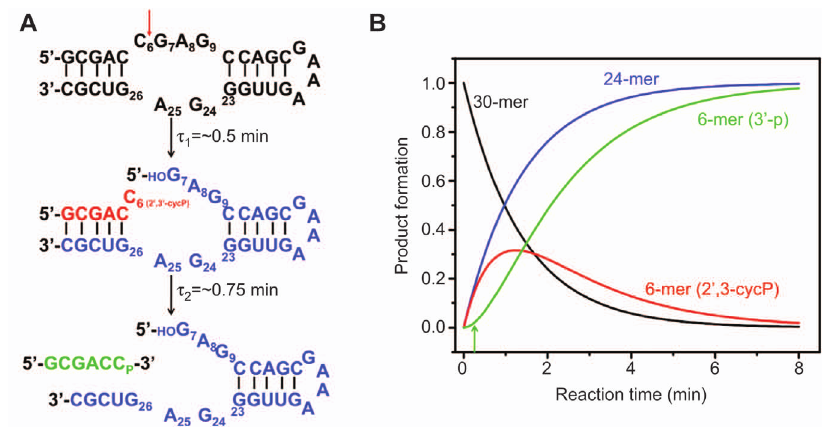
Figure 2 Cleavage reaction of leadzyme and kinetics. (A) The two-step cleavage reaction. The red arrow indicates the scissile bond. The first step cleaves the parental 30-mer hairpin (black) to generate the 24-mer hairpin with 5 9 -OH group (blue) and the 6-mer with 2 9 ,3 9 -cyclic phosphate group (red). The second step hydrolyzes the 2 9 ,3 9 -cyclic phosphate group to generate the 6-mer with 3 9 -monophosphate (green). The lifetimes of the two steps are ; 0.5 min and ; 0.75 min, respectively in 300 m M Pb 3 q . (B) Kinetic profiles of the cleavage reaction. Curves are color-coded to match those in (A). The green arrow points to the lagged appearance of the 6-mer (3 9